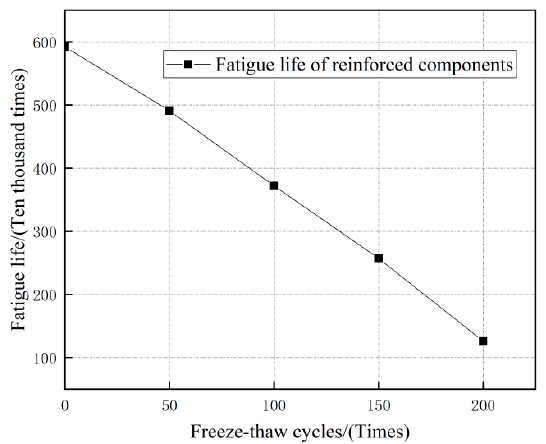
Figure 22. Fatigue life of reinforced components under different freeze–thaw